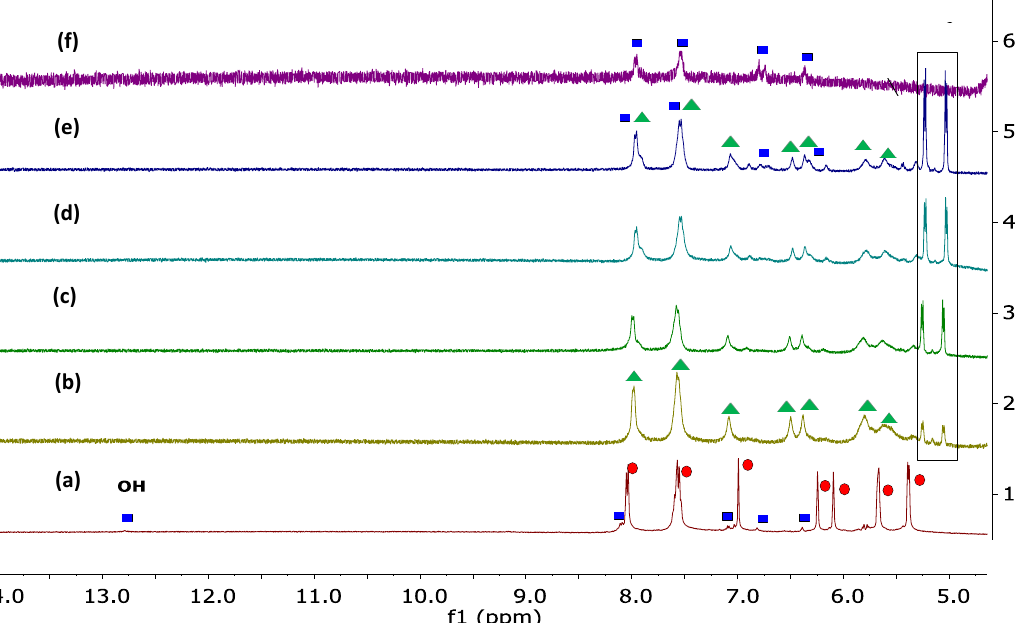
Figure 4. Aromatic area of 1 H NMR spectra (400 MHz) for L4-Ru : in DMSO- d 6 after 24 h; and in DMSO- d 6 :D 2 O (3:2) (400 MHz): ( a ) L4-Ru after 24 h in DMSO- d 6 ; ( b ) t = 0; ( c ) t = 3 h; ( d ) t = 7 h; ( e ) t = 24 h; ( f ) free ligand HL4 . Red circles, L4-Ru(S); green triangles, [( p -cym)Ru(L4)(H 2 O)]+; blue squares, HL4 . The resonances inside the black rectangle correspond to [( p -cym) 2 Ru 2 ( µ -OH) 3 ]. Time values refer to the addition of D 2 O.